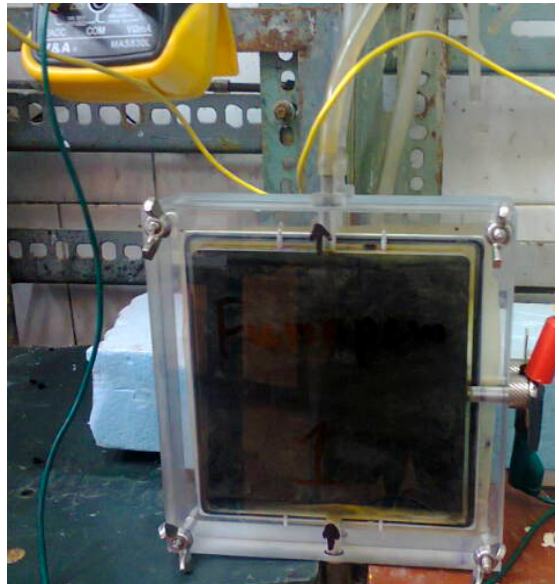
Figure 6. Experimental set-up of a single rectangular fuel cell with 100 sq/cm electrode and membrane area.